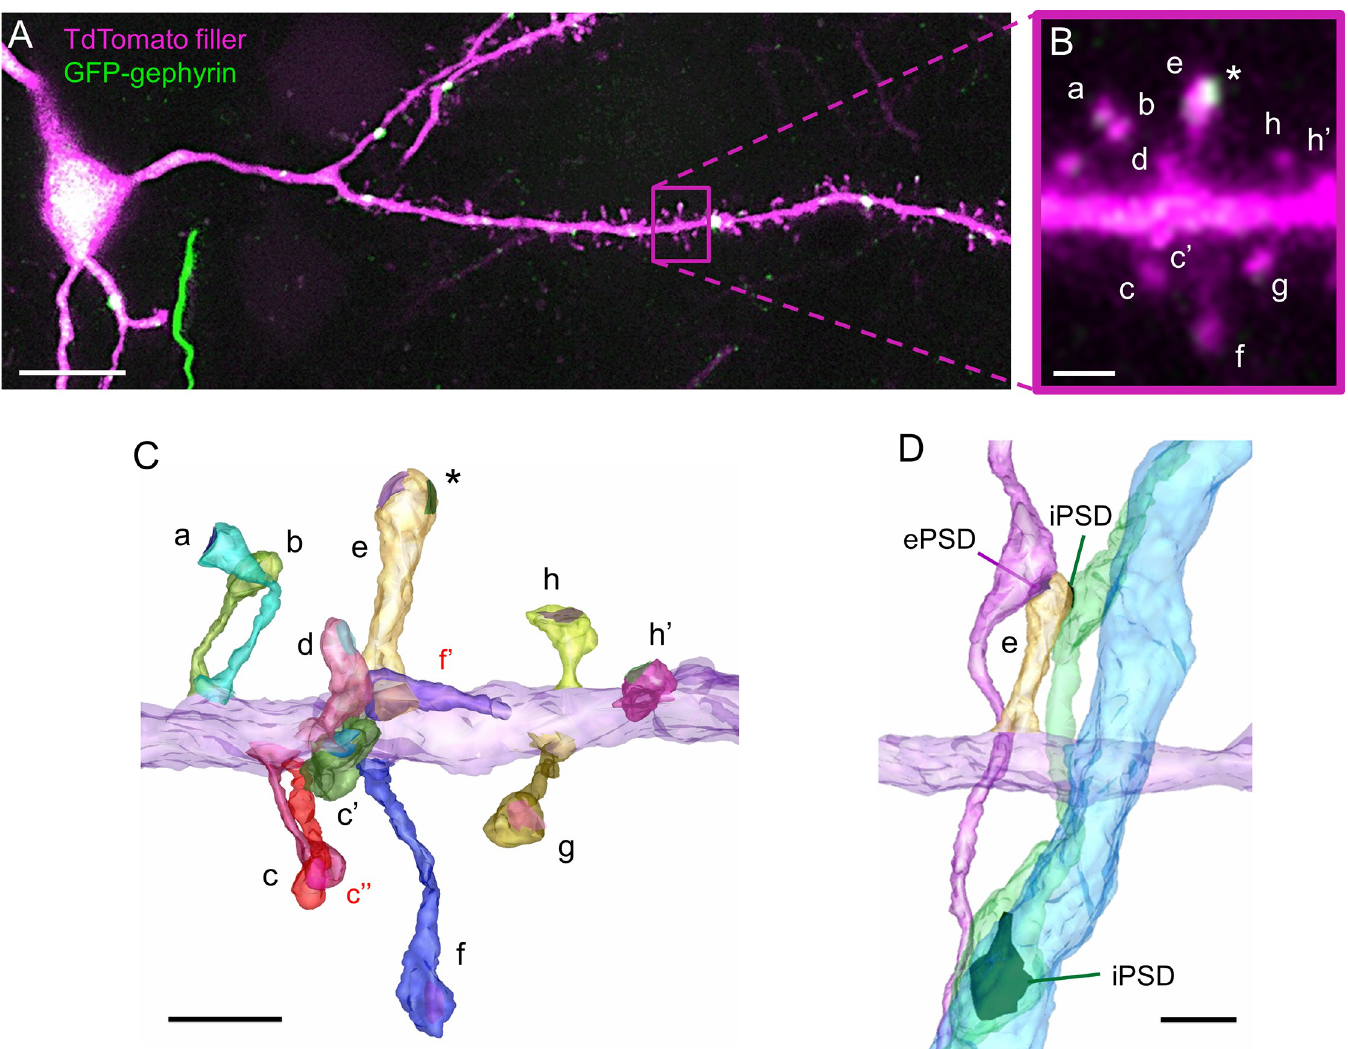
Fig 4. Identification of excitatory and inhibitory synapse on DiSs using CLEM. (A) Confocal image of basal dendrites of a cortical L2/3 PN that was electroporated with cytosolic TdTomato and GFP-GPHN to label inhibitory synapses. The magenta rectangle outlines the region enlarged in B. (B) Enlargement of a portion of the dendrite in A harboring several dendritic spine (lettered). Spine “e” contains a cluster of GFP-GPHN (asterisk) and corresponds to a putative DiS. (C) 3D-EM reconstruction of the same dendritic fragment as in B. Dendritic shaft is colored in purple; individual spines and PSDs are colored randomly. Spines visible in EM but not in LM are labelled in red. The iPSD (colored in green) on spine “e” is identified based on the position of the GFP-GPHN cluster (asterisk in B and C). GFP-GPHN- negative PSDs are defined as excitatory. (D) 3D-EM reconstruction of spine “e” (yellow) with its presynaptic partners (magenta and green). As the “green” axon also targets a neighboring dendritic shaft (blue), it is defined as inhibitory. Scale bars: A: 10 μ m; B, C, D: 1 μ m. CLEM, correlative light–electron microscopy; DiS, dually innervated spine; EM, electron microscopy; ePSD, excitatory postsynaptic density; GFP-GPHN, GFP-tagged gephyrin; iPSD, inhibitory PSD; LM, light microscopy; L2/3, layer 2/3; PN, pyramidal neuron; PSD, postsynaptic density; 3D-EM, three-dimensional electron